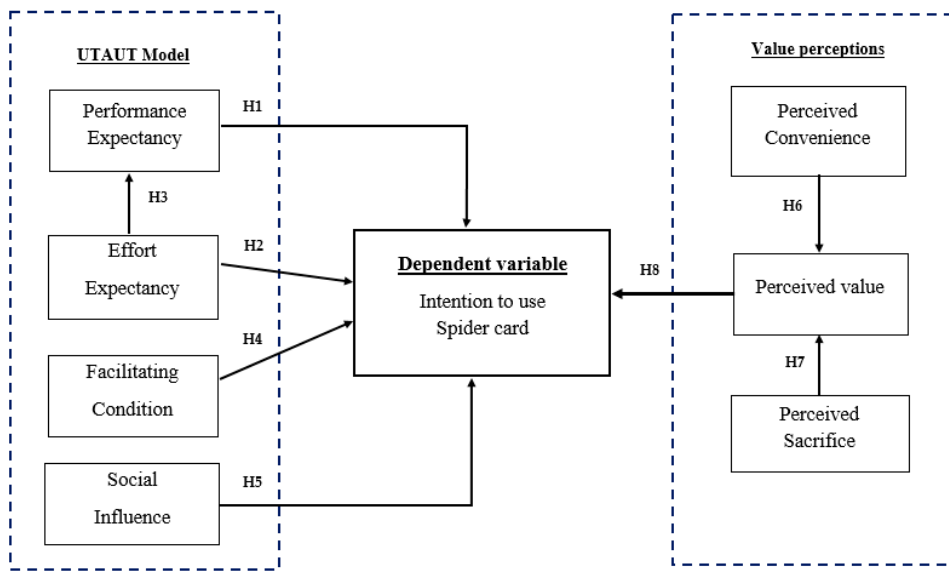
Figure 1. The proposed research model.